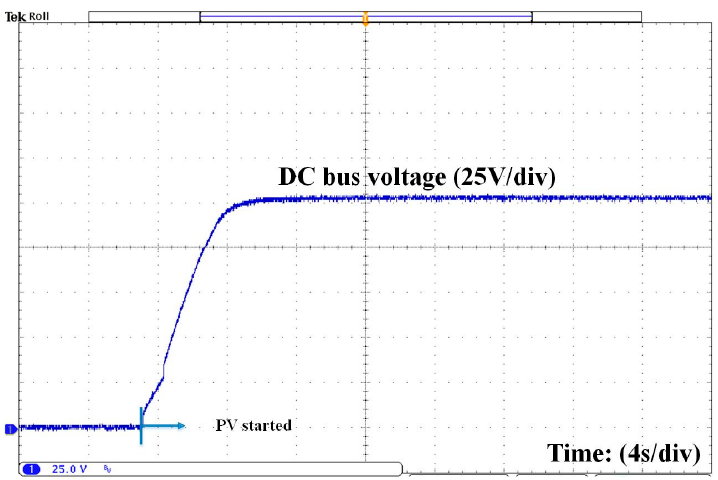
Figure 15. Bus behavior on the two photovoltaic emulators (PVEs) ignition.